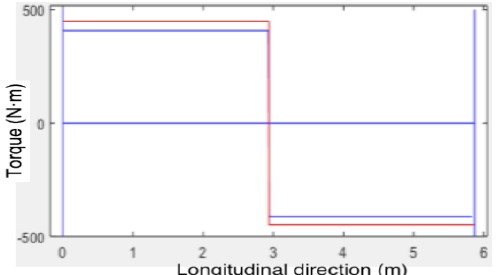
Figure 8. Torque obtained from the deformed point clouds for a concentrated load of 6000N applied at mid span. Red lines correspond to the theoretic values (solving elastic problem) of torque, and blue lines are obtained values for the beam tested. We can observe that the difference is in any case under